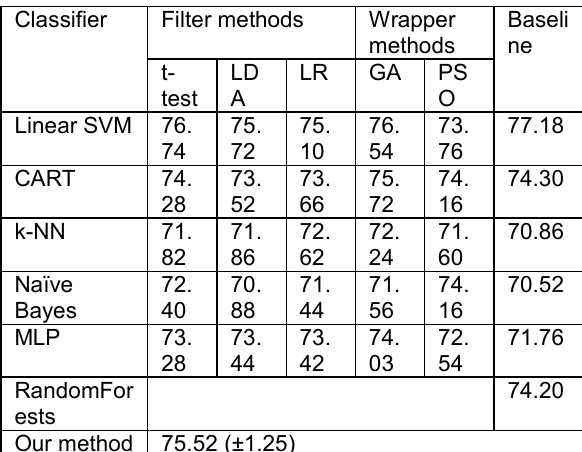
Table 2. Performances of different classifiers over the German credit